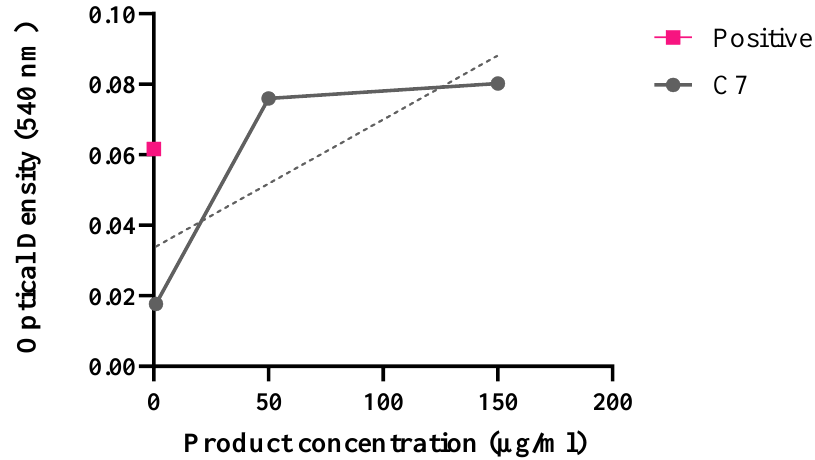
Figure 10. Product activity on human adenovirus-2 (hAdV2) and coronavirus 229E (hCoV229E) at different viral loads.